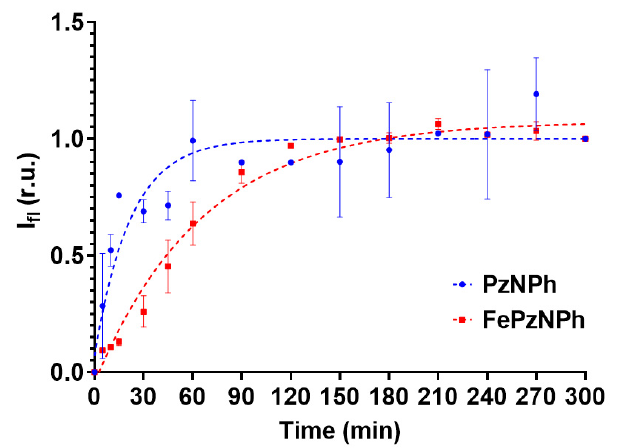
Figure 5. Dynamics of PzNPh and FePzNPh accumulation in human epidermoid adenocarcinoma A431 cells. The fluorescence signal was normalized to the maximum value recorded at the end of the incubation period to eliminate the effect of cell culture density on the result. The data are presented as the mean values ± SD ( n = 3).